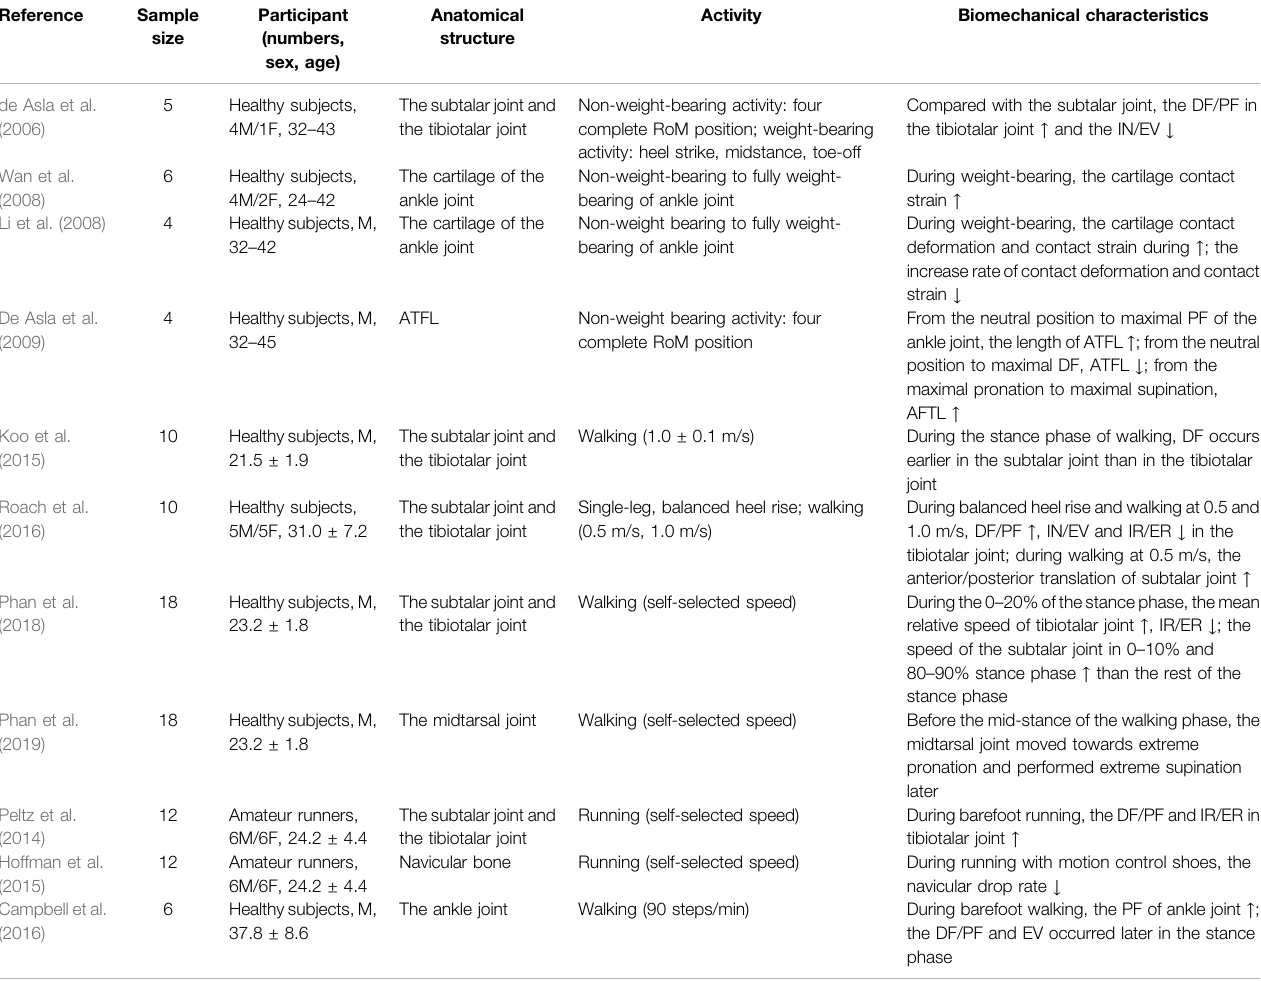
TABLE 2 | Summary of DFIS studies on healthy